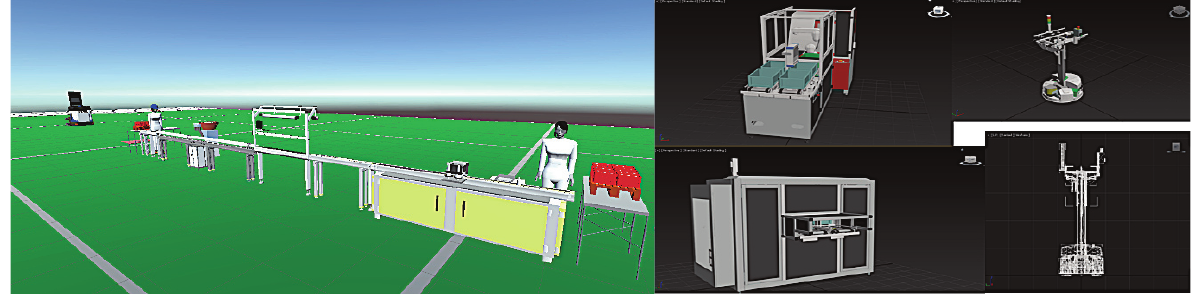
Fig. 8. Use cases’ model via Unity3D and